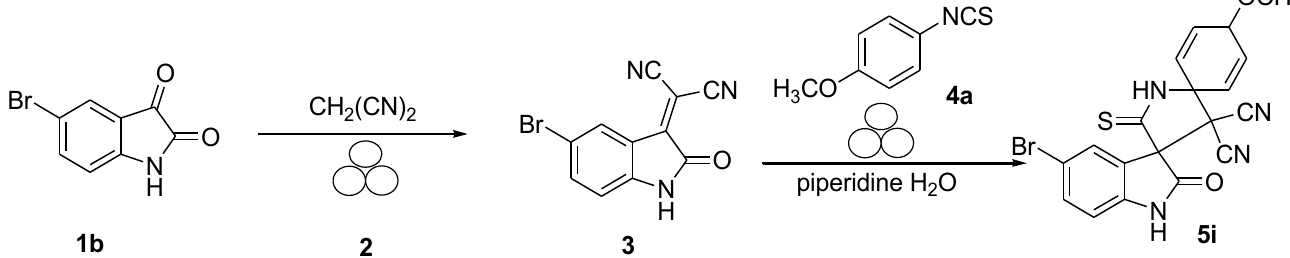
Figure 4. Synthesis of spiroindole – pyrrolidine derivative ( 5i ) using 5-bromo isatin (1b) under mechanochemical activation.